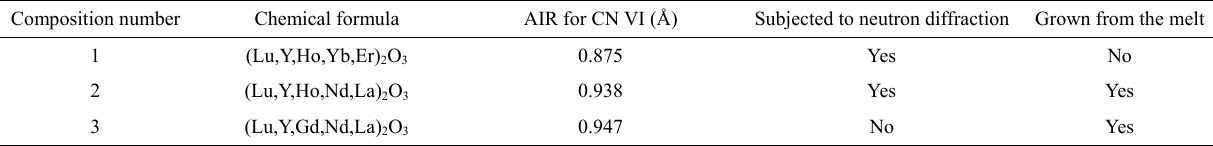
Table 2 List of high-entropy RE sesquioxide compositions and their respective AIR for CN VI [26] Composition